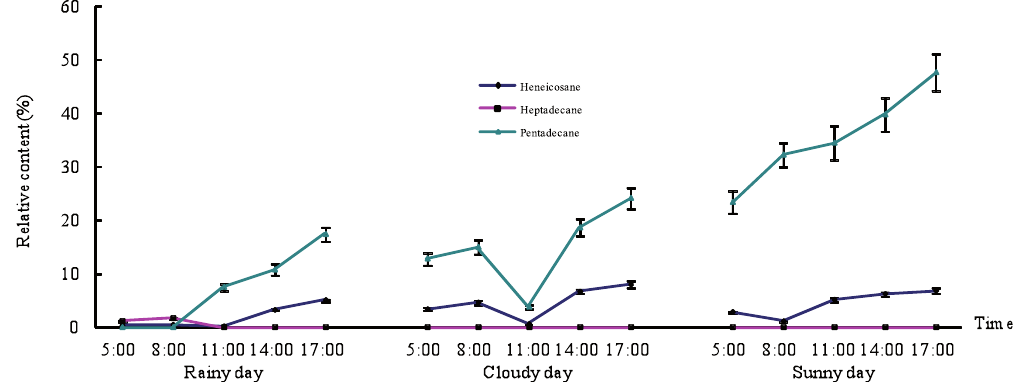
Fig. 7: Diurnal dynamics of alkanes in volatile emissions from flowers of four seasons